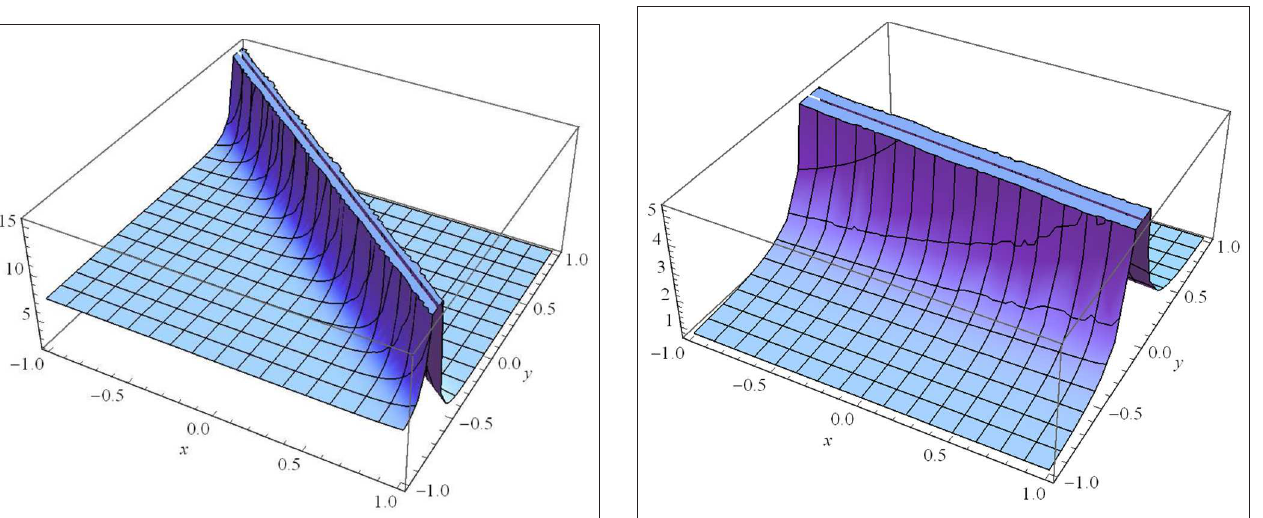
: ϑ II 8 ( x , y , t ) FIGURE 2 | 1 =1, ϑ 2 = − 1, ϑ 3 = 1, µ 1 = 1, µ 2 = 1, µ 3 = 1, α 0 = 5 | | 1, β 0 = 2, λ 0 = 3, α 1 = 4, β 1 = 5, λ = 6, η 0 = 1, t = 0.1 .